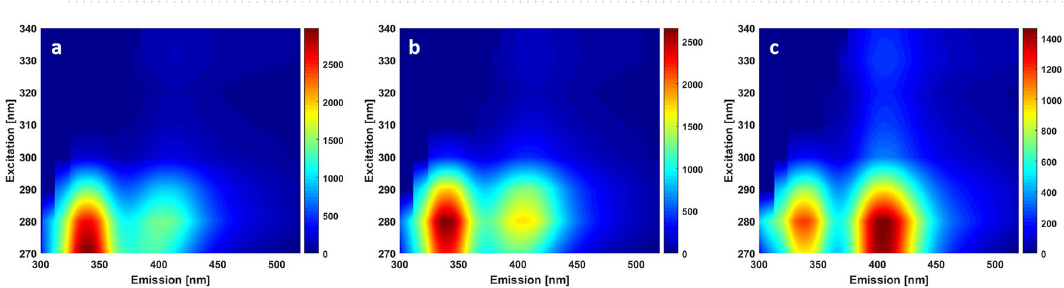
Figure 1. Spectral analysis using deep UV and NIR excitation range. ( a ) Normalized mean fluorescence intensity (NFI) spectra of 10 control, 7 grade I and 8 grade II meningioma samples acquired at 275 nm excitation. ( b ) Normalized mean fluorescence intensity (NFI) spectra of 24 control, 14 grade I and 11 grade II meningioma samples acquired at 890 nm excitation.